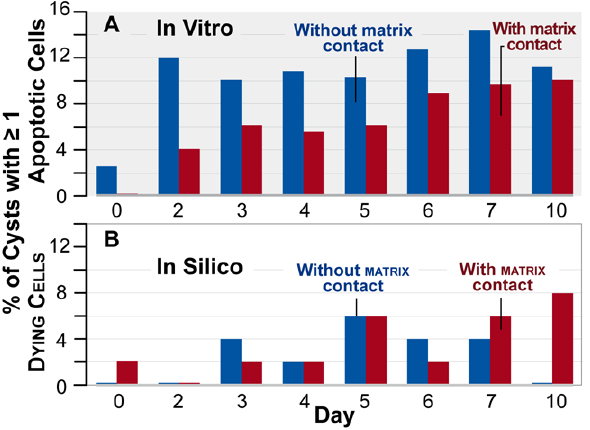
Figure 5. Percentage of cysts with dying cells. (A) In vitro data reproduced from [9]. (B) ISMA data from 50 CYSTS over ten DAYS . Blue bars: percentage of cysts observed to have apoptotic cells without matrix contact. Red bars: percentage of cysts observed to have apoptotic cells with matrix contact.